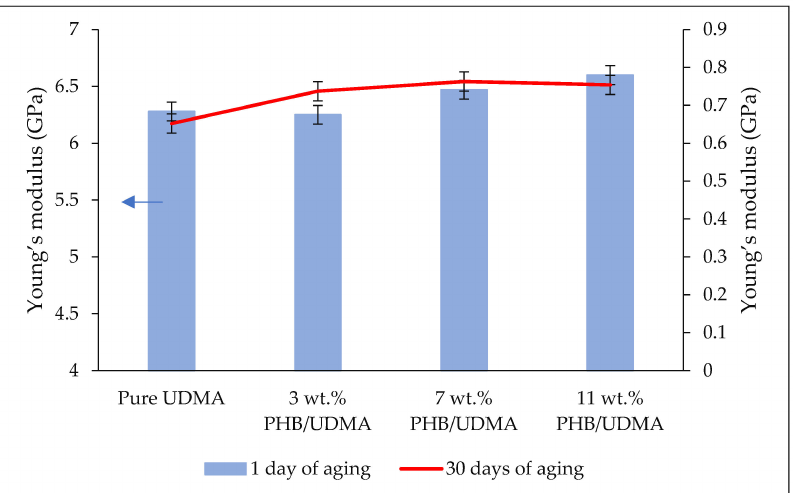
Figure 3. Comparative results of Young’s modulus of varied 3D printed PHB/UDMA after a day and a month of